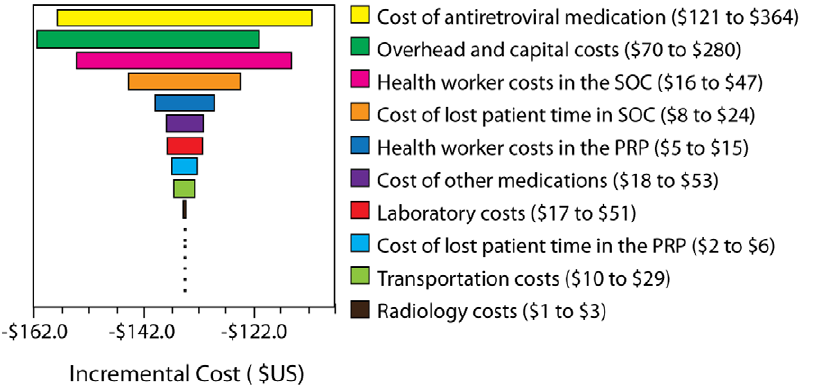
Figure 1. Tornado diagram of univariate sensitivity analysis showing the impact on incremental costs comparing Pharmacy-only Refill Program (PRP) versus Standard of Care (SOC).